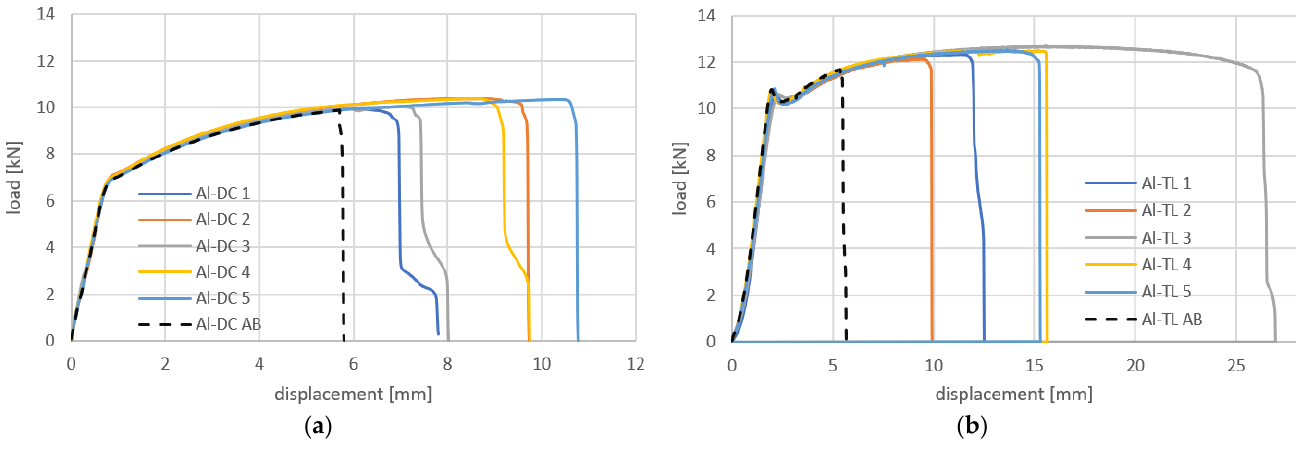
Figure 18. Load–displacement curves for ( a ) Al-DC and ( b ) Al-TL joints made by resistance spot welding + AB, compared with adhesive bonding only (black dashed line).